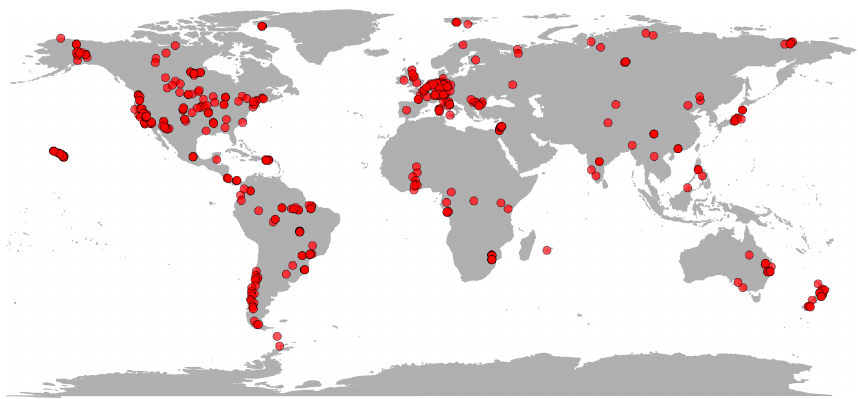
Figure 4. Geographic location of sites currently included in ISRaD v1.0. Circles that appear darker in color indicate multiple overlapping sites at the resolution of the map.